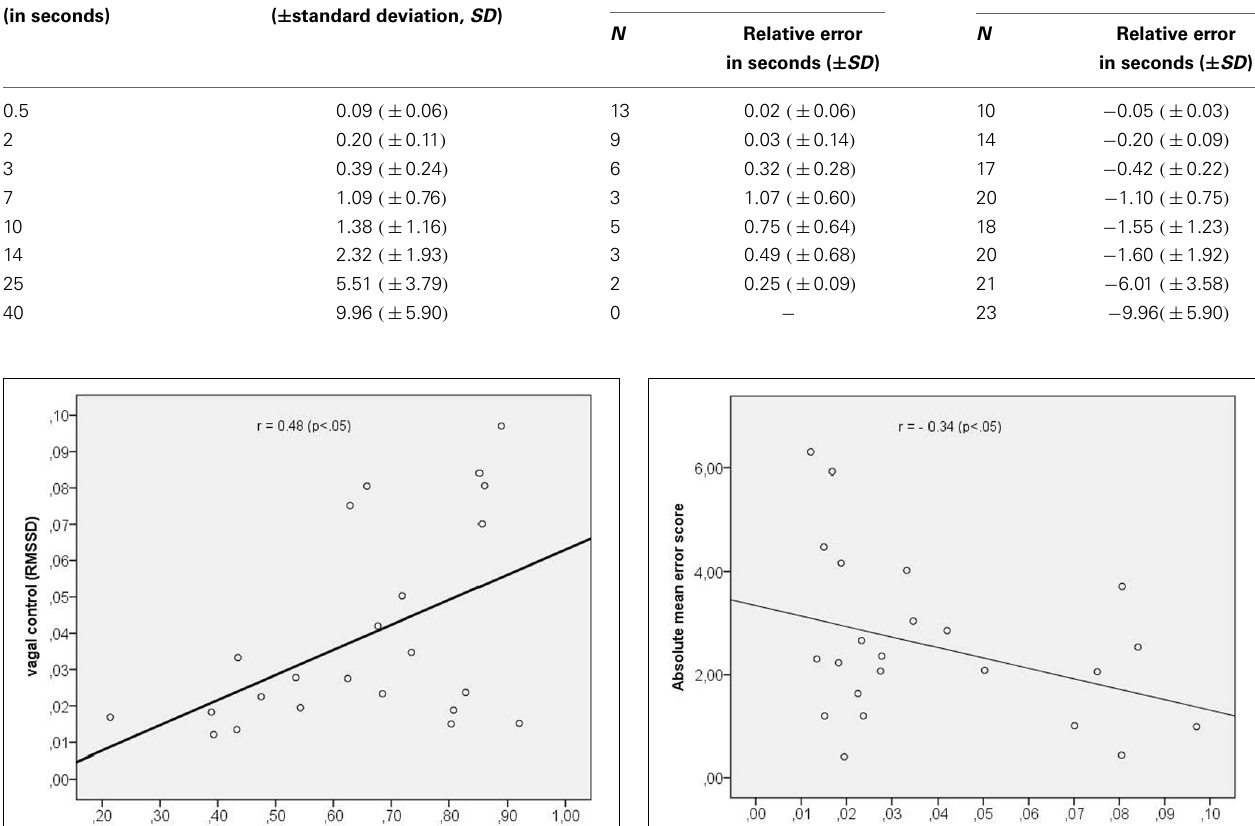
As follows from Figure 5G , the difference from the random case is especially pronounced for the RE events for 25 s interval, 23 reaching the significance with 20%